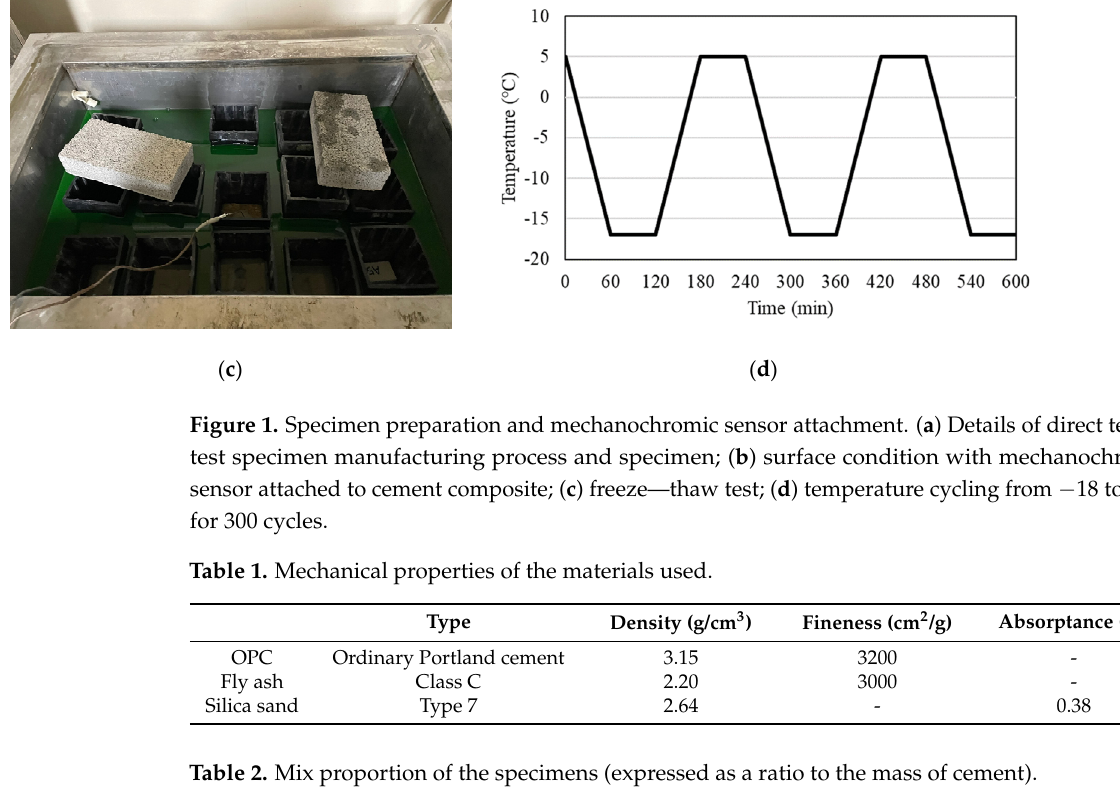
Table 2. Mix proportion of the specimens (expressed as a ratio to the mass of